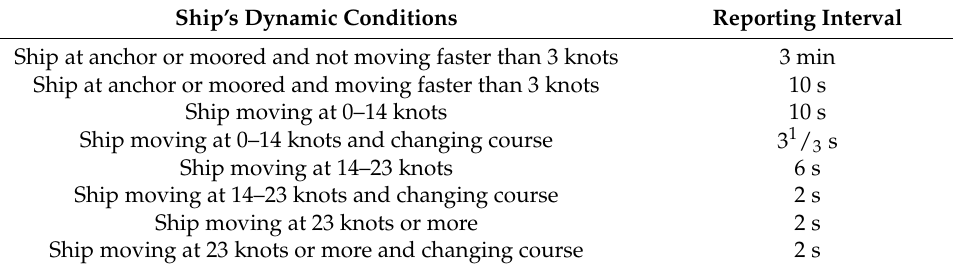
Table 1. Reporting intervals of Class A shipborne mobile equipment. Ship’s Dynamic Conditions Reporting Interval